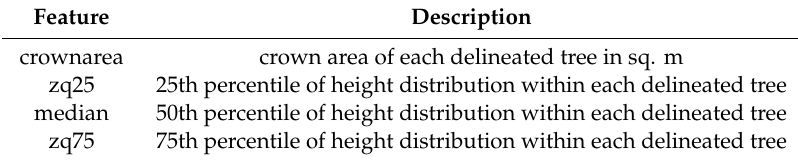
Table 7. Elevation features extracted from the high-density photogrammetric PPC or CHM used in this